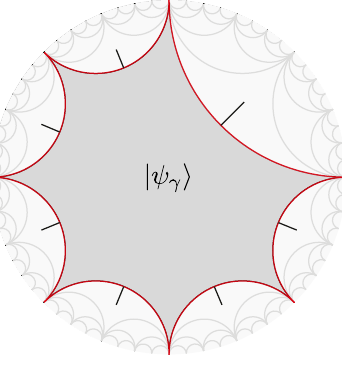
Figure 14 . Holographic